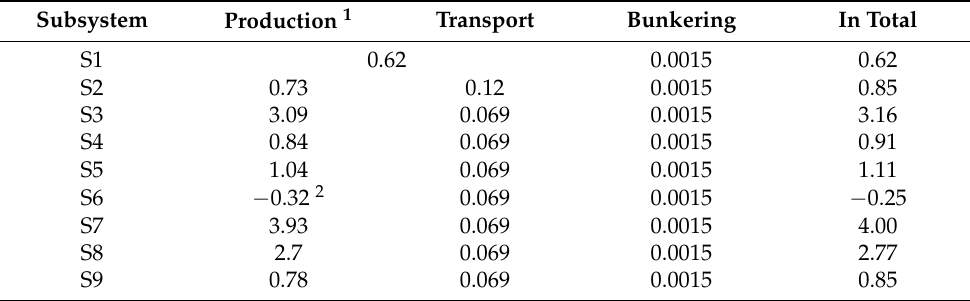
Table 2. GHG emission data for WTT calculation (ton CO 2 -eq/ton fuel). Subsystem Production